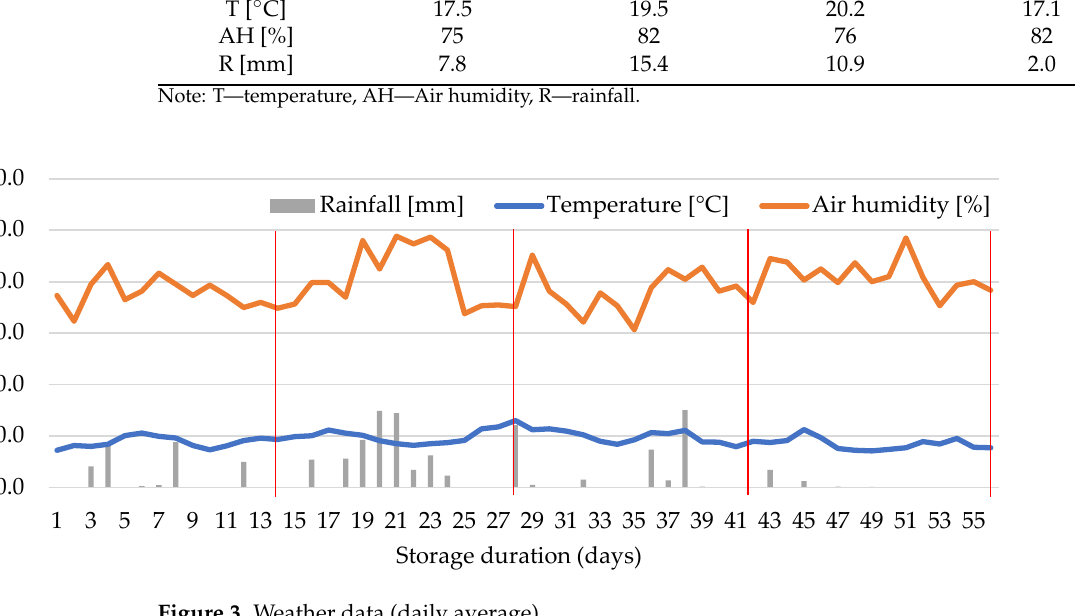
Figure 3. Weather data (daily average). Table 2. Mean temperature, air humidity and rainfall for storage duration.